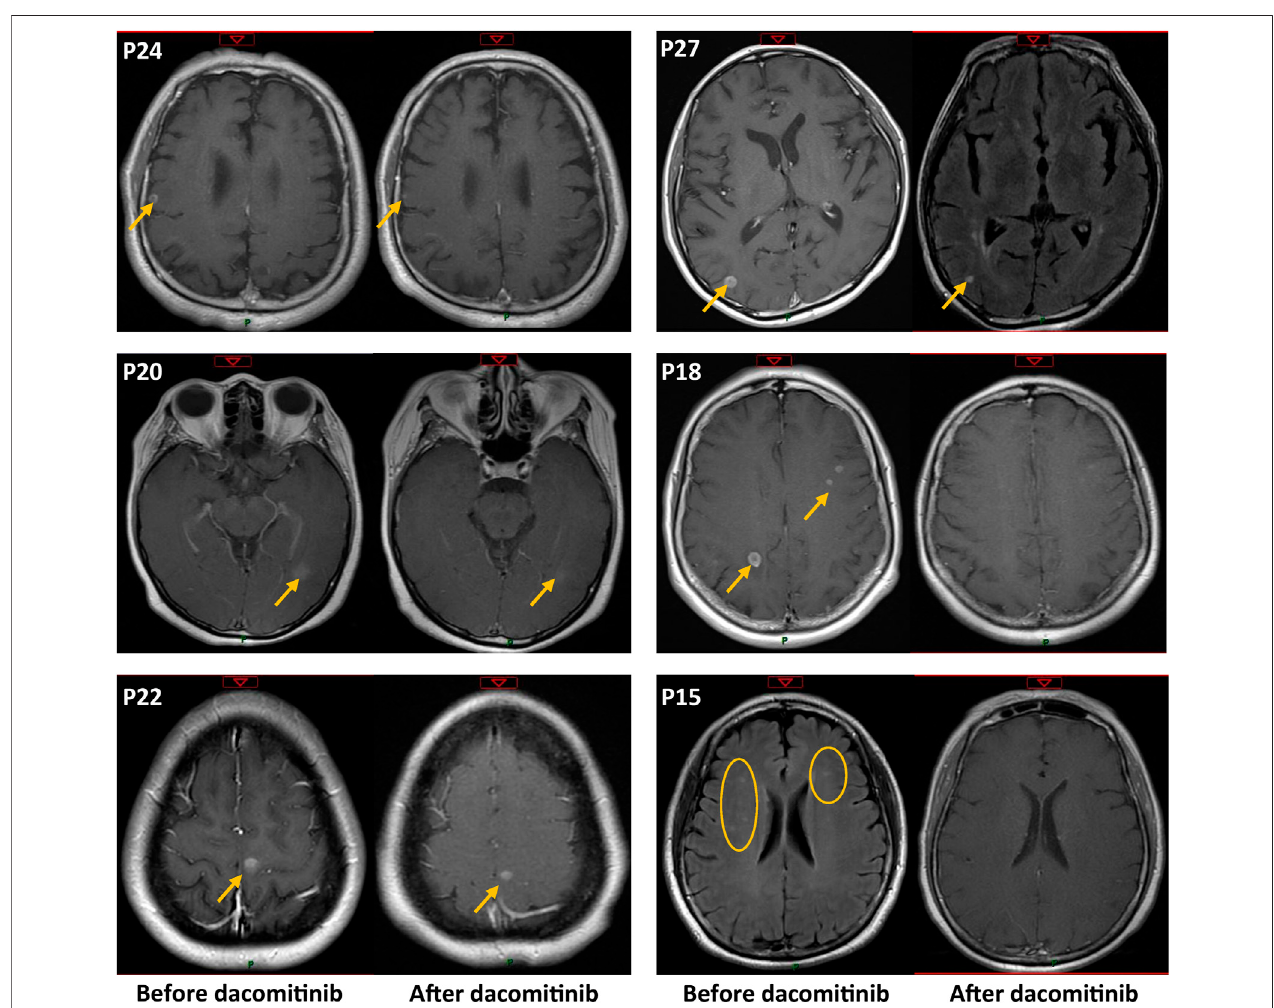
FIGURE 4 | Enhanced MRI con fi rmed intracranial metastasis control before and after dacomitinib treatment in six representative patients. The patient number is consistent with Figure 1 but not Figure 2 .